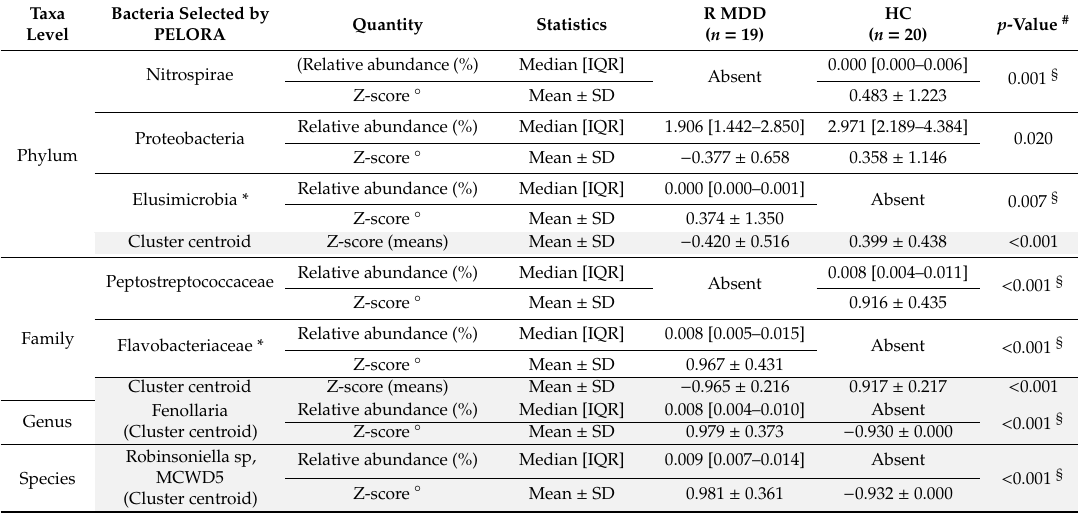
Table 5. Results from the penalized logistic regression analysis (PELORA) algorithm which identifies pathways of bacterial populations that best discriminate responsive MDD patients (R) from healthy controls (HC).